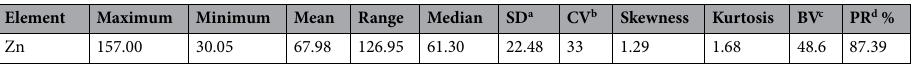
Table 1. Statistics of the collected soil samples for Zn concentration (mg kg −1 ). a SD: standard deviation, b CV: coefficient of variation in %. c BV: the soil Zn concentration background value of Inner Mongolia Autonomous Region 15 . d PR: the percentage of contaminated samples (Threshold = 48.6 mg kg −1